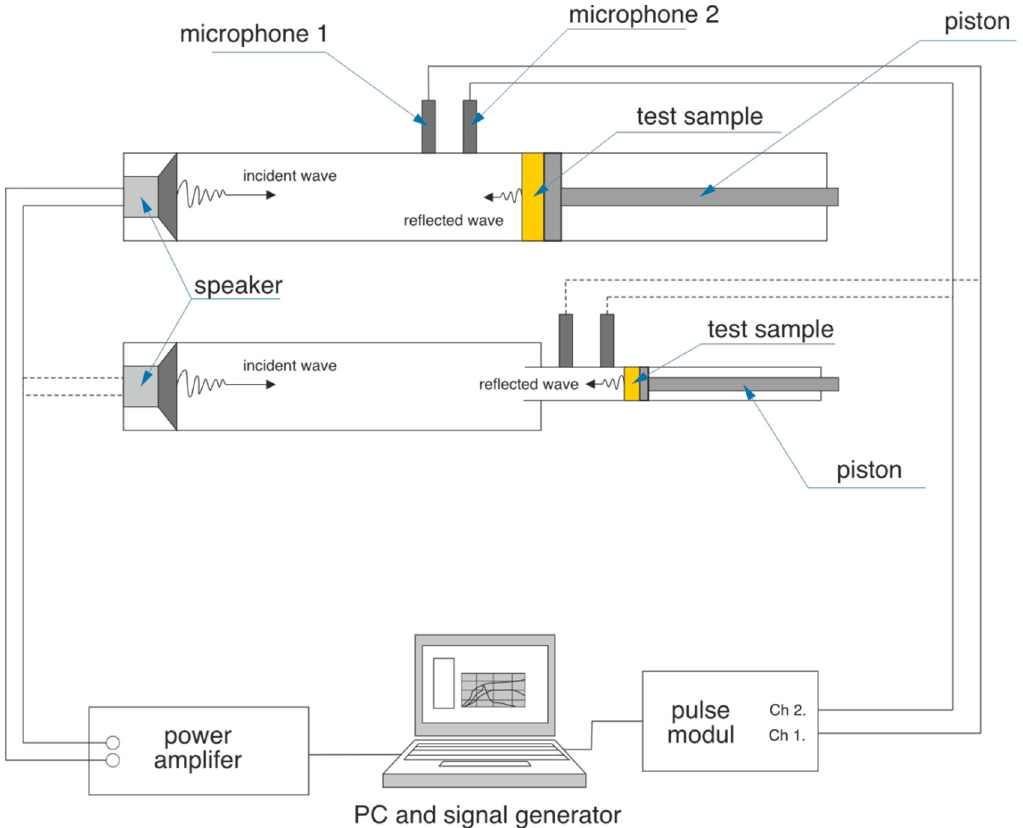
Figure 3. Scheme of device for measuring of sound absorption coefficient.